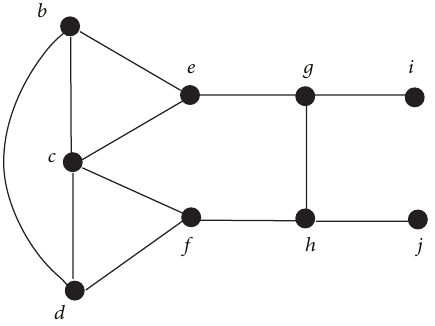
Figure 2: A local skeleton recovered from the marginal distribution of {𝑏,...,𝑗} .